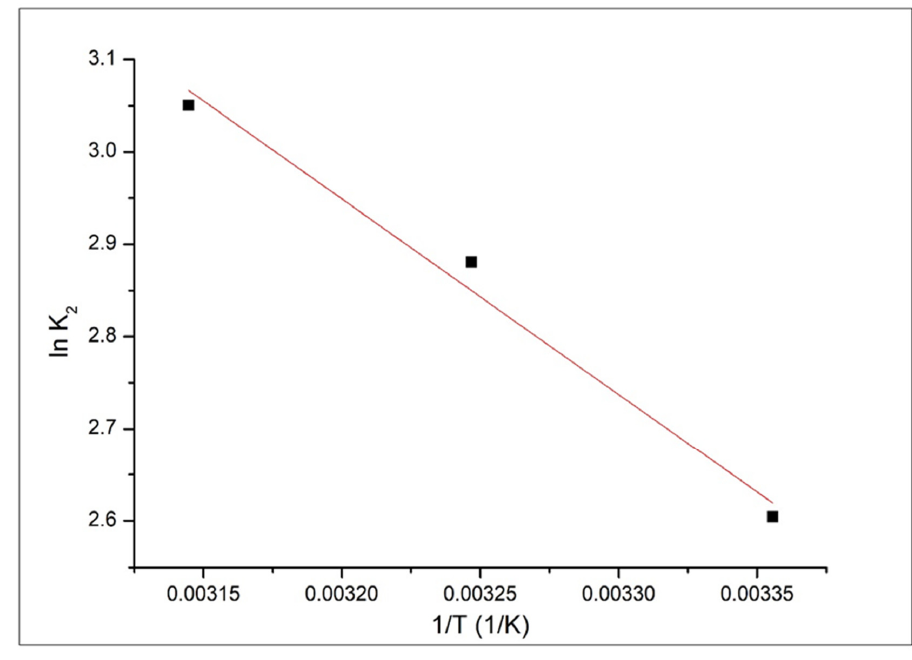
Figure 10. ln K 2 = f ( 1 / T ).